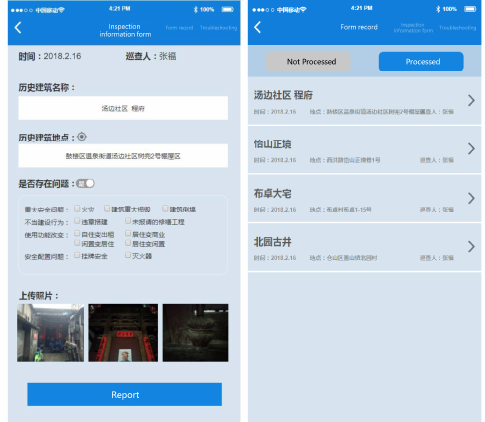
Figure 4. Inspection of historical buildings by